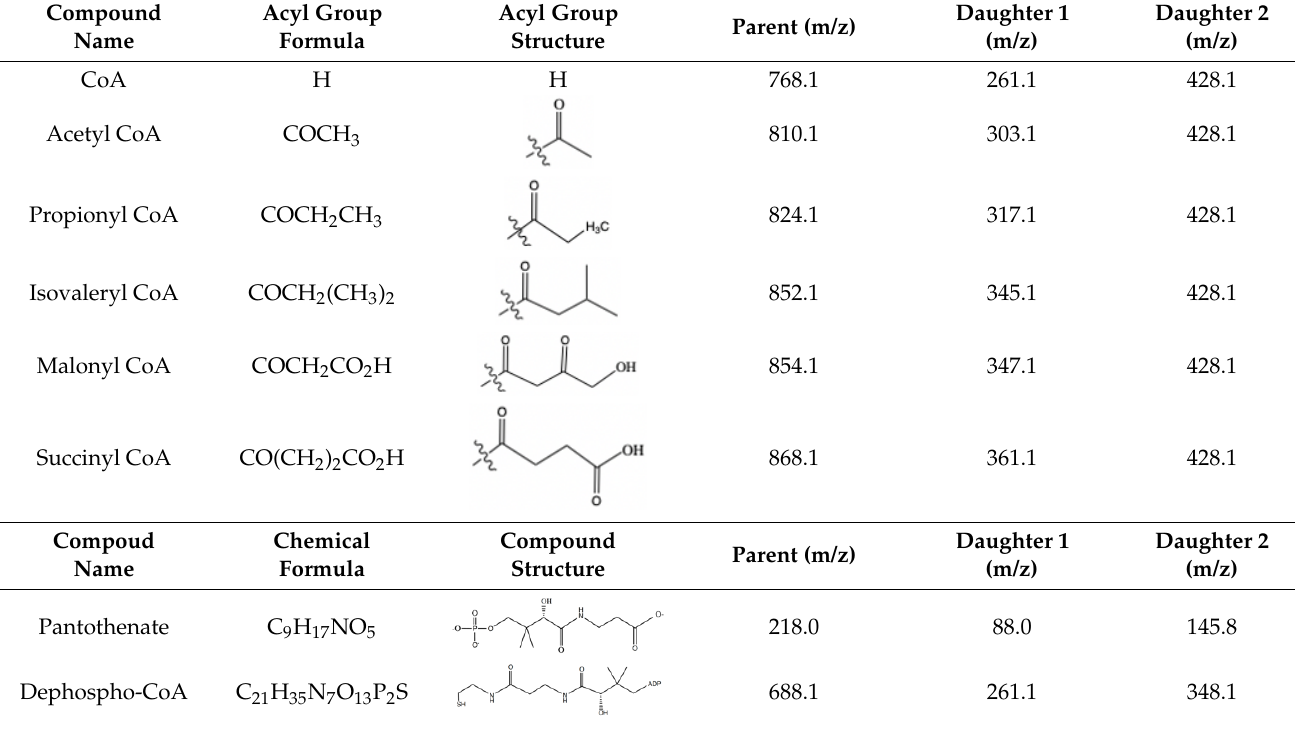
Table 1. Parent and daughter ion m/z for short-chain acyl CoAs, dephospho-CoA, and pantothenate.